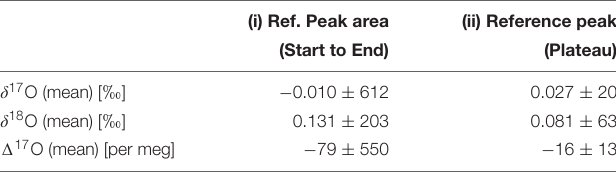
TABLE 1 | δ 17 O, δ 18 O, and (cid:49) 17 O of O 2 (reference) for the continuous flow method by changing reference peak area calculations by using the whole reference area and only plateau of the reference